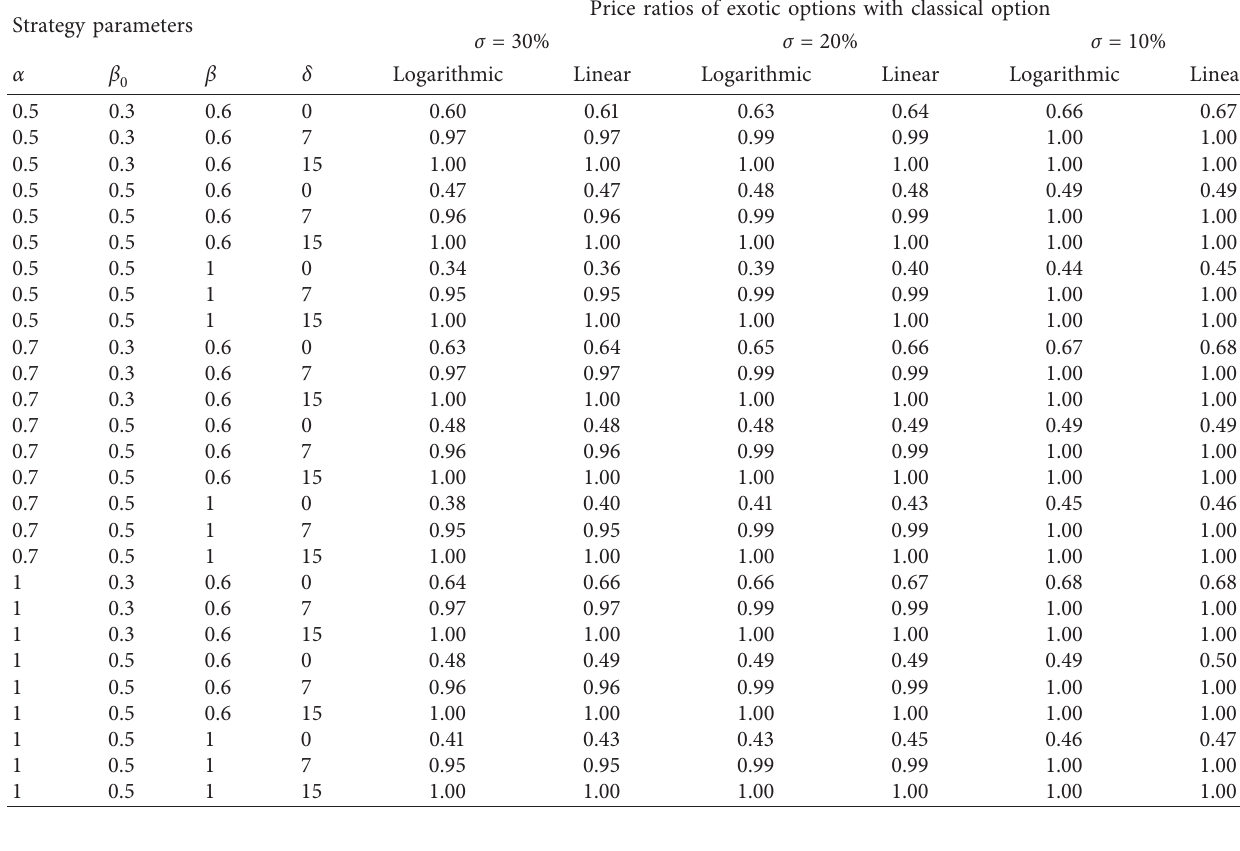
Table 2: Price ratios of exotic options considering the proactive hedging options relative to classical European options in terms of α , β , β and σ